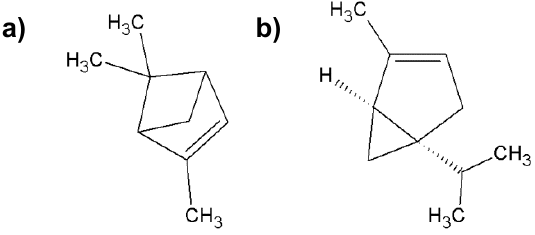
Figure 2. Characteristic compounds found in frankincense; ( a ) α -pinene; ( b ) α -thujene.